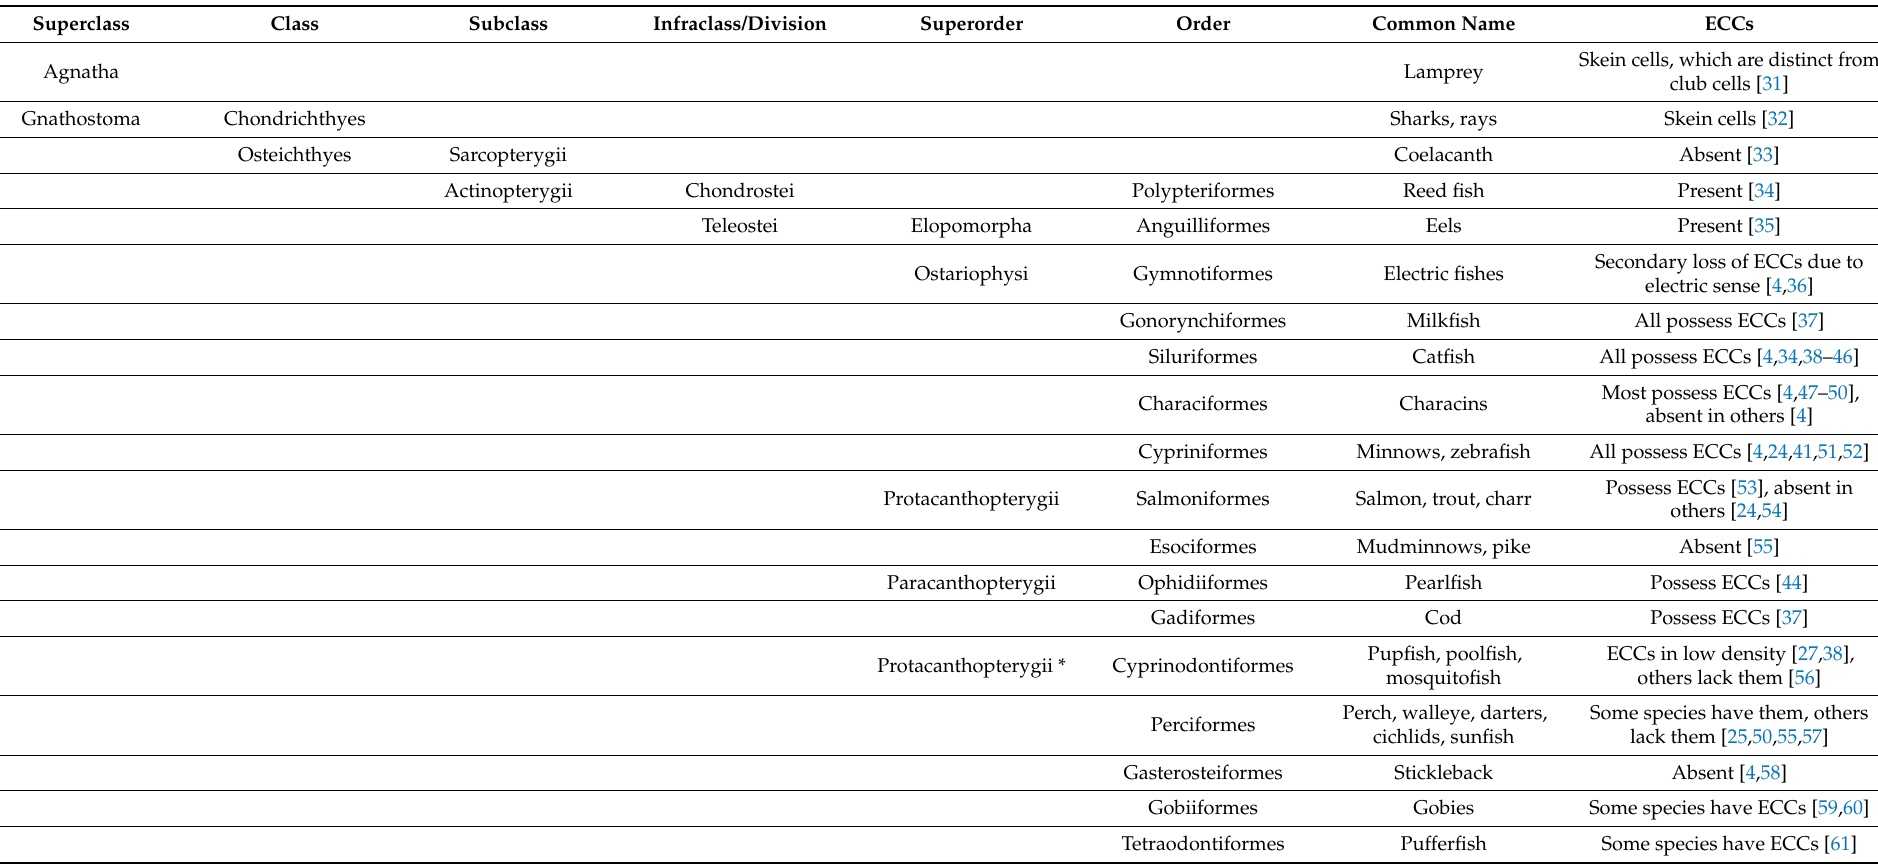
Table 1. Phylogenetic distribution of epidermal club cells in